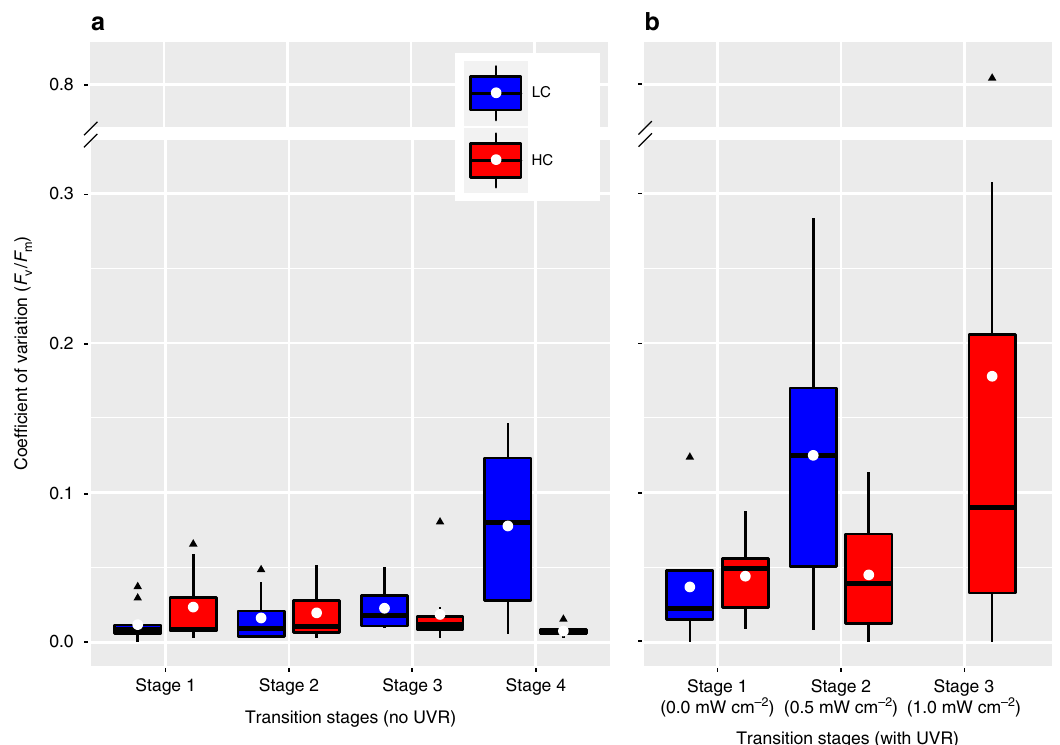
Fig. 5 Increased coef fi cient of variation in photosynthetic ef fi ciency may be an early warning sign of collapse. Coef fi cient of variation in F v / F m of replicates over the growth cycle in each stage of the experiment for cultures grown in LC and HC conditions, without ( a ) and with ( b ) UVR during the stress test. A white dot represents the mean, median is indicated with a black horizontal line for each boxplot, and outliers are shown with black